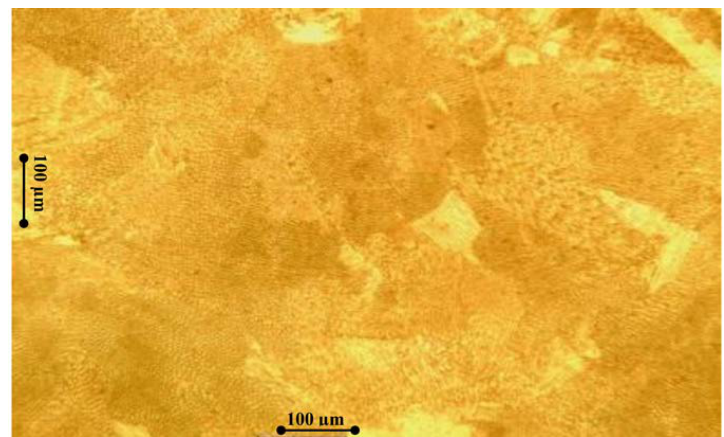
Figure 7. Multilayered build #36 (ideal P f :T s ), Vickers: 227 ± 9.